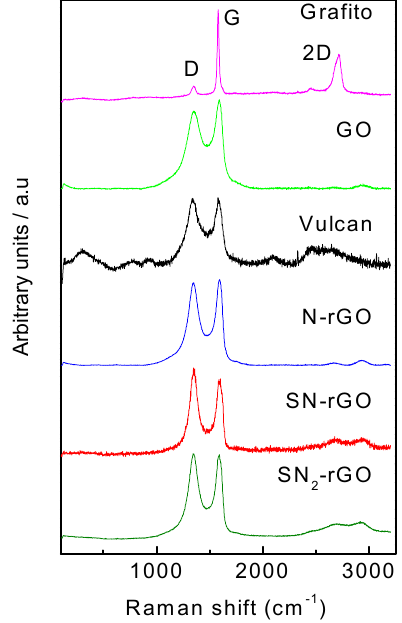
Figure 3. Raman spectra for all studied materials.